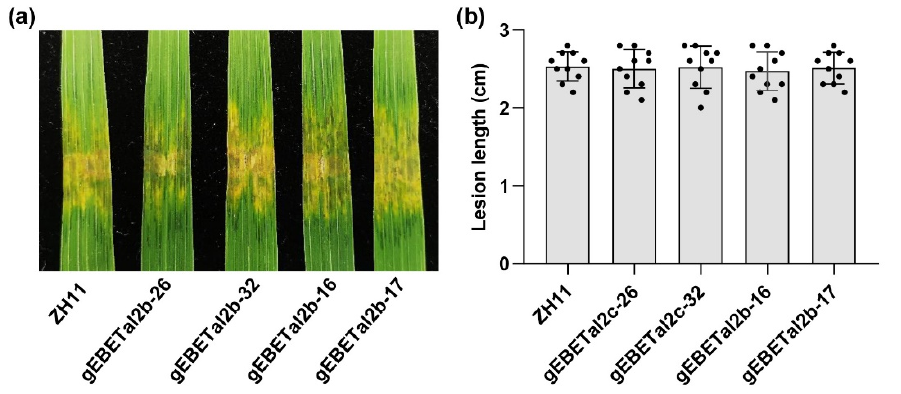
Figure 5. Single mutants of EBE in either the OsF3H 04g or OsF3H 03g promoter had no effect on rice susceptibility to Xoc strain HGA4. ( a ) Image of lesion expansion in ZH11, gEBETal2b-16, gEBE- Tal2b-17, gEBETal2c-26 and gEBETal2c-32 lines at 14 dpi with HGA4. ( b ) Diagram of lesion lengths in ZH11, gEBETal2b-16, gEBETal2b-17, gEBETal2c-26 and gEBETal2c-32 lines at 14 dpi with HGA4. Data represent the means ± SD, n =